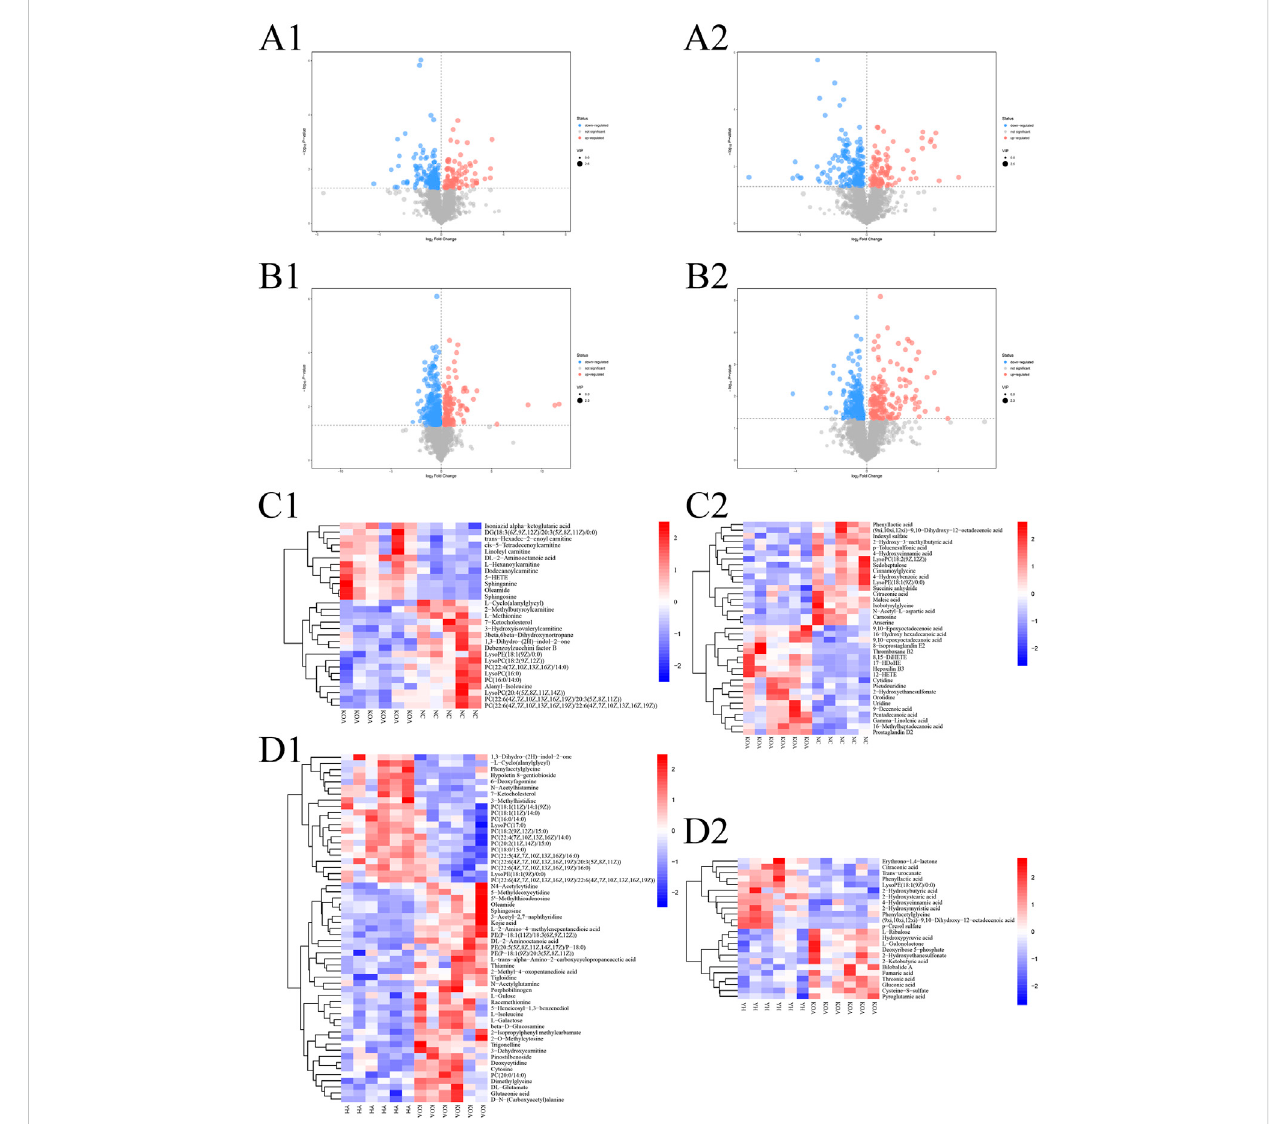
Multivariate statistical analysis of metabolite pro fi les in plasma. Volcano plot of comparison groups: KOA vs . NC (A1: positive ion, A2: negative ion); YH vs . KOA (C1: positive ion, C2: negative ion). Heatmap of comparison groups: KOA vs . NC (C1: positive ion, C2: negative ion); YH vs . KOA (D1: positive ion, D2: negative ion). Screening of differential metabolites by metabolomic analysis. Signi fi cantly upregulated metabolites are shown in red,signi fi cantly downregulated metabolites in blue, and non-signi fi cantly different metabolites in